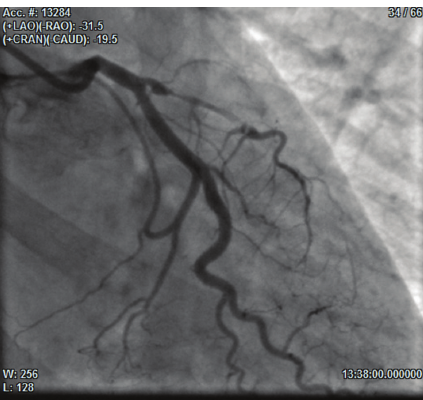
Figure 1: (31 ∘ RAO and 19 ∘ CAU): left anterior descending (LAD) ostial dissection, causing long proximal tract subocclusion and complete distal coronary occlusion.